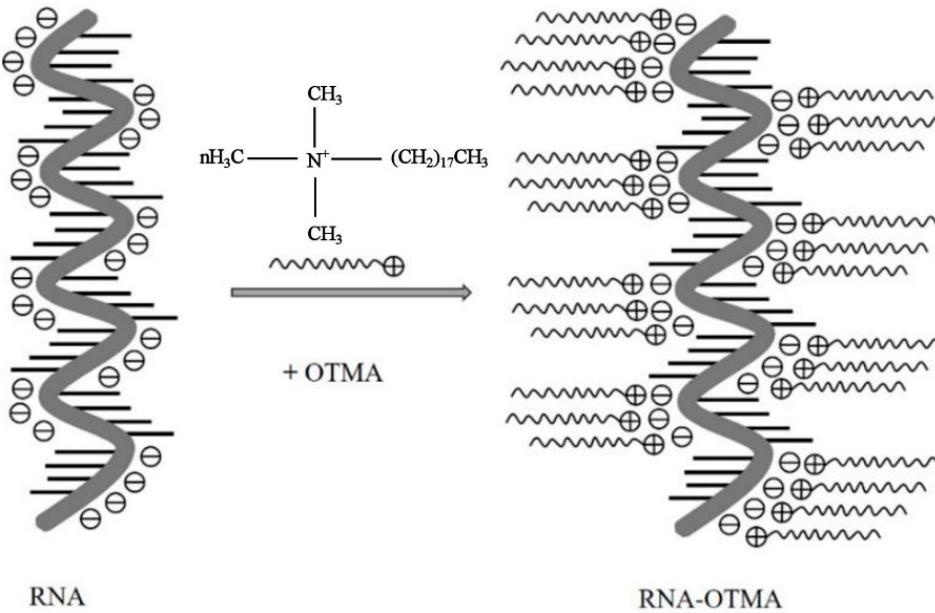
Figure 2. Schematic diagram of the preparation of RNA–OTMA lipid complexes.